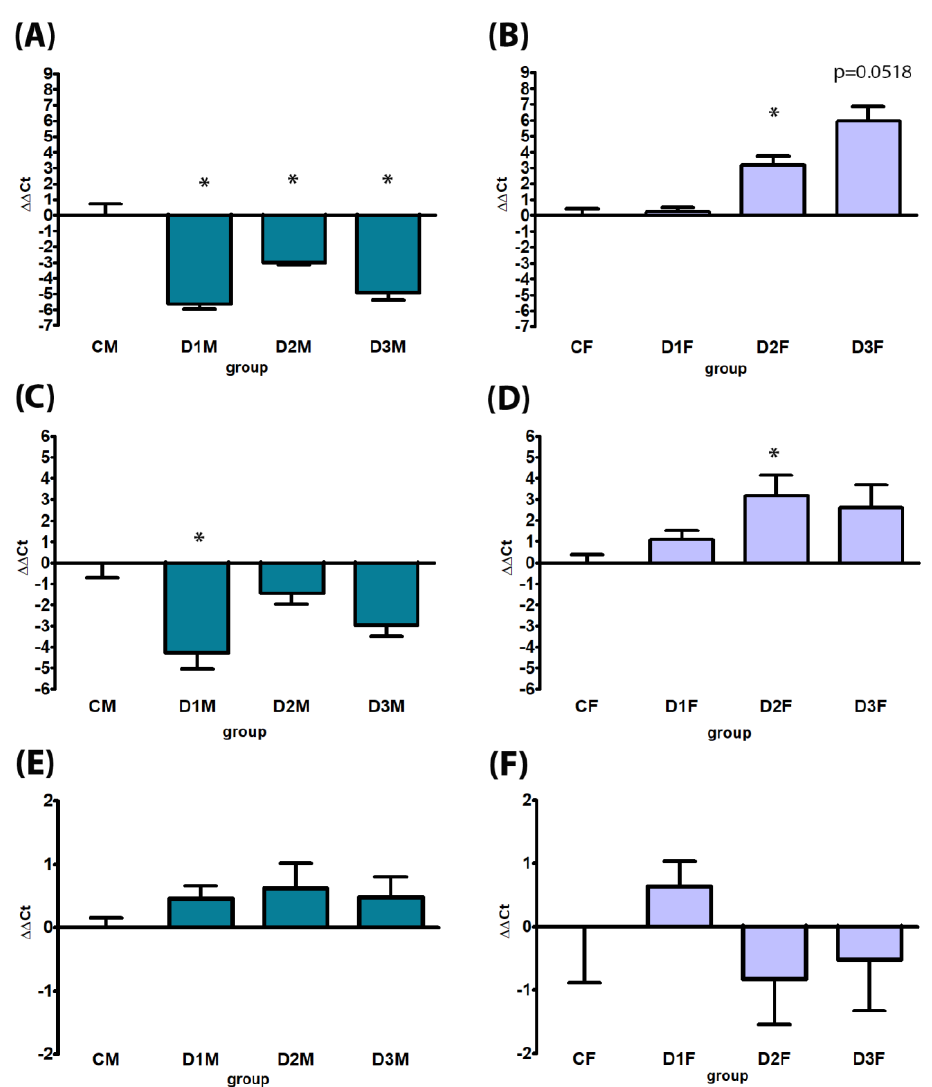
Figure 9. Comparison between gene expression analysis of sex (male)-specific genes CYP2C11 (Panels ( A , B ), CYP3A18 (panels ( C , D ) and AR (Panels ( E , F ) by real-time PCR in male and female rat livers. Male rats, panels ( A , C , E ), subcutaneously treated with different doses of estradiol valerate plus cyproterone acetate five times a week, for 2 weeks: CM 0 — sesame oil, D1M 0.09 + 0.33, D2M 0.09 + 0.93, and D3M 0.18 + 0.33 mg. Female rats, panels ( B , D , F ), subcutaneously treated with different doses of testosterone enanthate two times a week, for 2 weeks: CF 0 — sesame oil, D1F 0.45, D2F 0.95 , and D3F 2.05 mg. Data are presented as mean ∆∆Ct values ± standard deviation, with control samples as calibrators and GAPDH as the reference gene. Statistical significance: * p < 0.05 Mann – Whitney test.